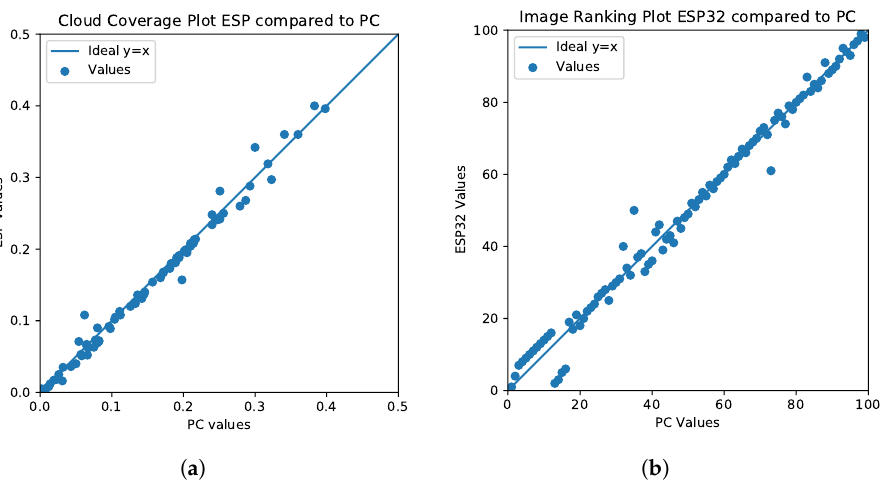
Figure 12. Comparison of PC results vs. embedded device results on FACSAT-1 images. ( a ) Cloud coverage: PC vs. embedded device; ( b ) Rank: PC vs. embedded